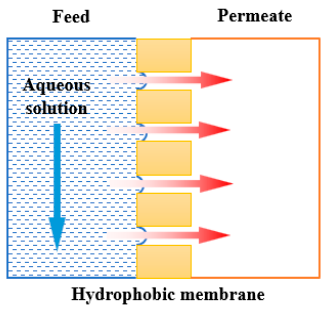
Figure 6. Principle of membrane distillation (MD) process.